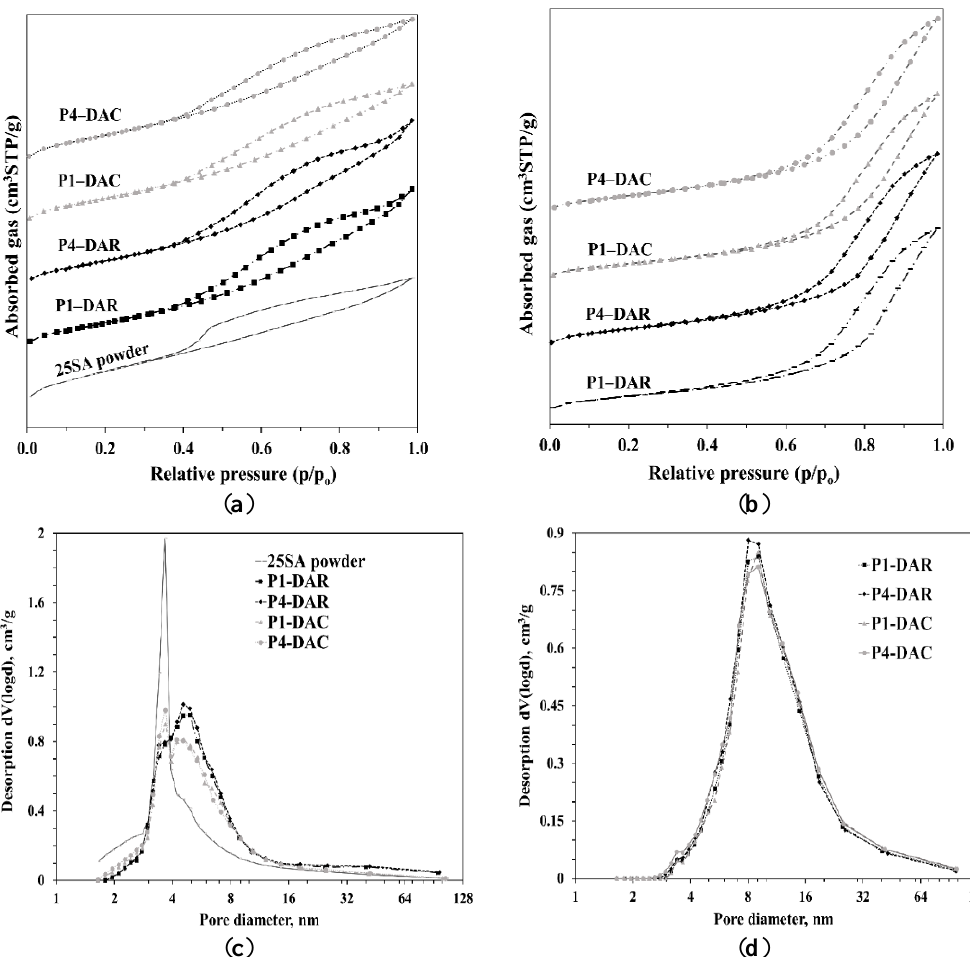
Figure 7. ( a ) and ( b ) N 2 adsorption–desorption isotherms; ( c ) and ( d ) pore diameter distributions Figure 7. ( a , b ) N 2 adsorption–desorption isotherms; ( c , d ) pore diameter distributions of the spray-dried 25SA microspheres of the spray-dried 25SA microspheres calcined at 550 and 750 °C, respectively. The 25SA sample calcined at 550 and 750 ◦ C, respectively. The 25SA sample (powder) was the one used for the preparation of the (powder) was the one used for the preparation of the microspheres .